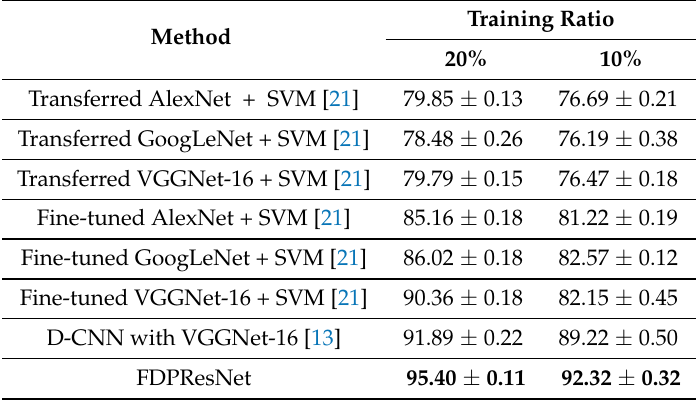
Table 1. Comparison of accuracies and standard deviations (%) of different methods on the NWPU-RESISC45 dataset.